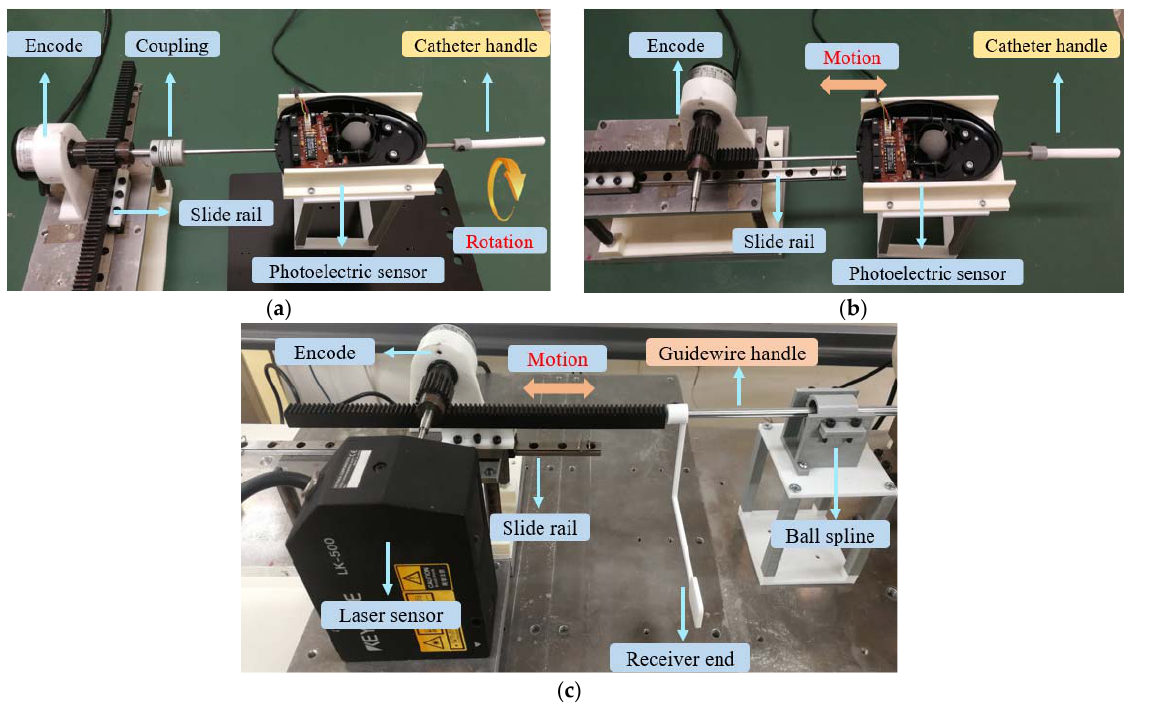
Figure 12. Accuracy evaluation experiments for the master operating device: ( a ) experimental setup